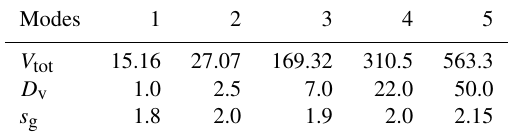
Table 4. Lognormal